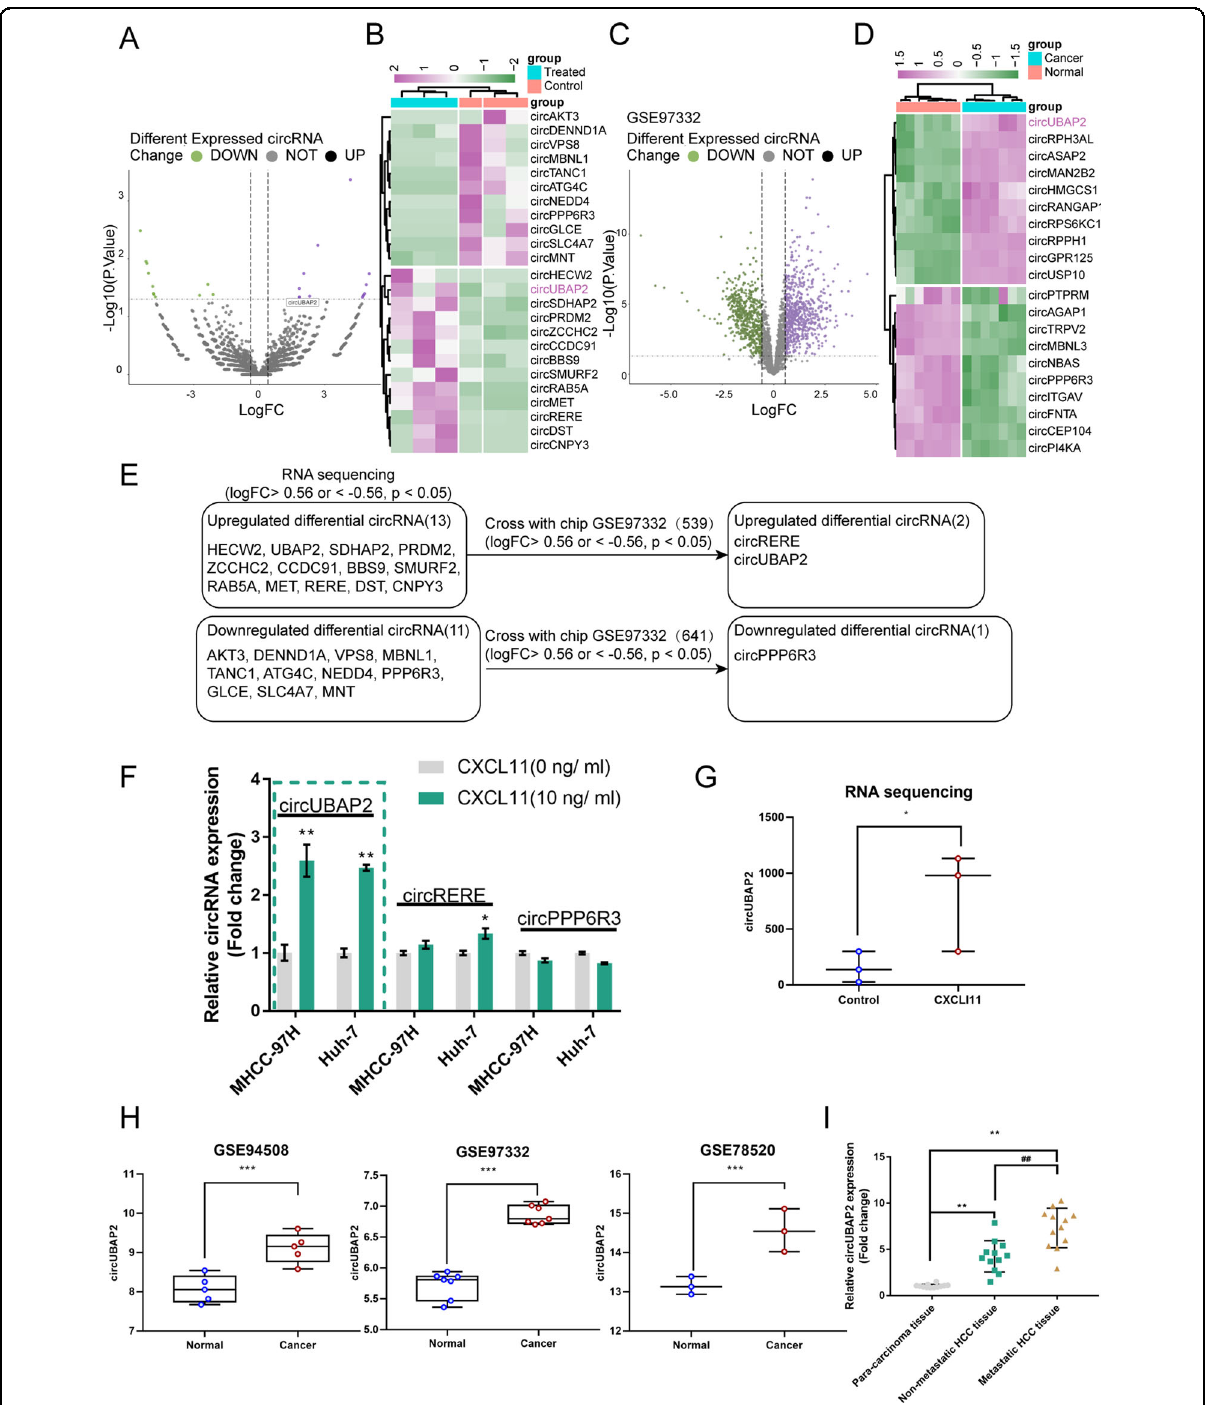
Fig. 3 Selection of circRNA related to the functions of CAF-secreted CXCL11 on HCC cell aggressiveness. A , B Volcano plot and hierarchical clustering heatmap showing differentially expressed circRNAs in CXCL11-treated MHCC-97H based on RNA sequencing. C , D Volcano plot and hierarchical clustering heatmap showing differentially expressed circRNAs between HCC and normal tissues based on GSE97332. E A schematic diagram showing the selection of circRNAs related to the functions of CAF-secreted CXCL11 on HCC cell aggressiveness based on our RNA sequencing data and online microarray expression pro fi les. These datasets intersected at the following circRNAs: circUBAP2 (upregulated), circRERE (upregulated), and circPPP6R3 (downregulated). F HCC cell lines MHCC-97H and Huh-7 were treated with CXCL11 (10ng/ml) and examined for the expression of circUBAP2, circRERE, and circPPP6R3 by real-time PCR. G The expression of circUBAP2 in CXCL11-treated or untreated MHCC-97H and Huh-7 cells. H The expression of circUBAP2 in normal liver tissues and liver cancer tissues based on GSE97332, GSE94508 and GSE78520. I The expression of circUBAP2 was examined in 12 cases of nonmetastatic HCC tissues, metastatic HCC tissues, and para-carcinoma tissues by real-time PCR. ** P <0.01, ## P